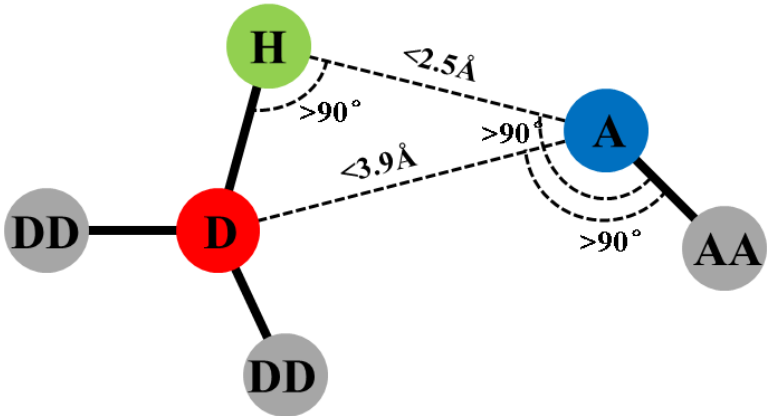
Figure 5. Geometric criteria for hydrogen bonds. D is the donor atom, H is hydrogen and A is the acceptor. DD is the donor antecedent and AA is the acceptor antecedent.